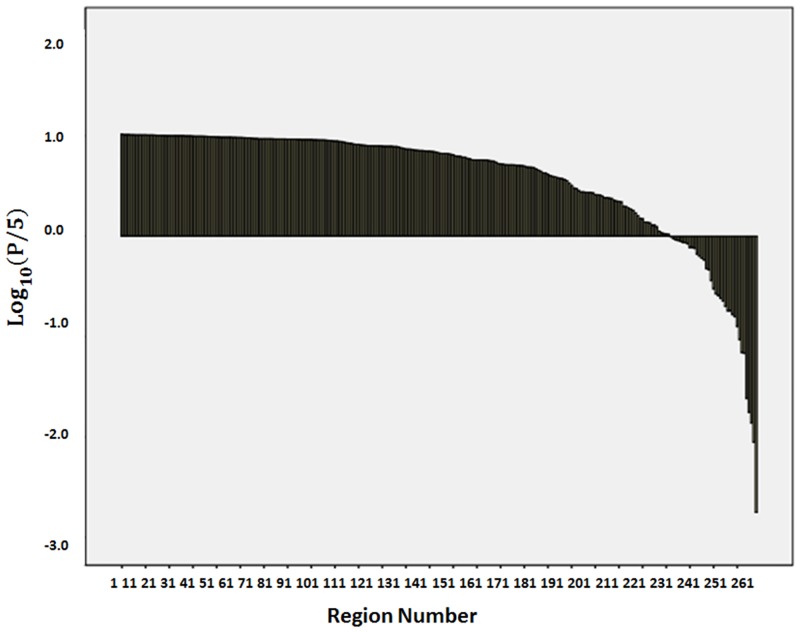
Distribution of Bonferroni-corrected p-values for protocol differences in 286 structures at Level 5.For better visualization, the p-values (P, y-axis) are presented as Log10(P/5). A p-value of 0.05 corresponds to -2 on the y-axis. At this threshold, two regions reached statistical significance.